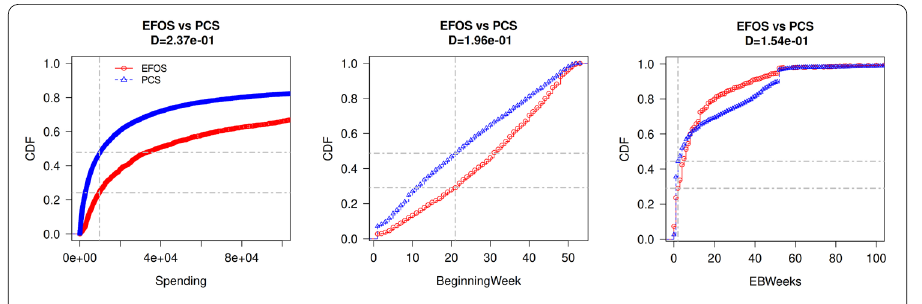
Figure 2 An example of a set of variables with significant differences between EFOS and PCS classes within the first government period. Left: Cumulative distribution function (CDF) for the variable Spending in the contracts of the EFOS class (red circles solid line) and in the PCS class (blue triangles dashed line). Center: CDF for the week of the year in which the contract began ( BeginningWeek ). Right: CDF for the duration of the contract ( EBWeeks ). The grey dashed line shows the value at which the CDFs showed the maximum